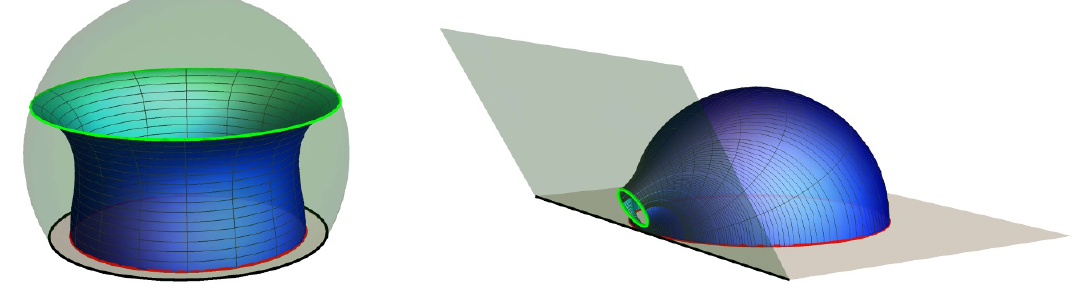
Figure 3 . Left: extremal area surface ^ (cid:13) con anchored to a disk A disjoint from a circular concentric A boundary (see section 2.2.2 and section 4.1) where Q (green spherical dome) is described by (2.24). Here (cid:11) = (cid:25)= 3 and R (cid:14) =R Q (cid:24) 0 : 85, which corresponds to r (cid:14) ; (see section 4.1.1). Right: extremal min surface ^ (cid:13) con anchored to a disk disjoint from a (cid:13)at boundary (see section 2.2.1 and section 4.2). A Here (cid:11) = (cid:25)= 3 and d=R can be obtained from the (cid:12)rst expression in (4.22) with the value of R (cid:14) =R Q of the left panel because the two con(cid:12)gurations shown in these panels are related through